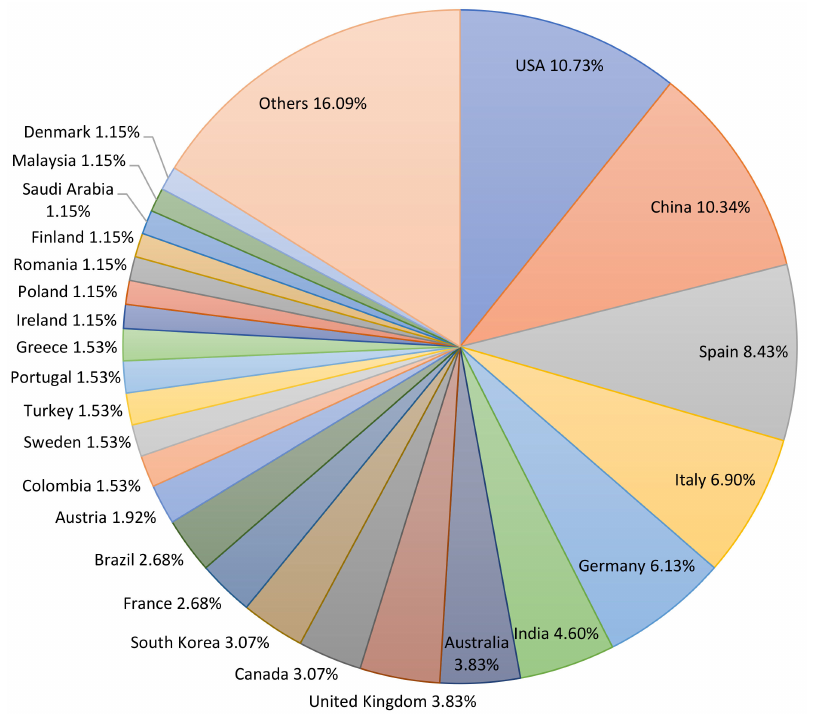
Figure 4. Percentage of countries’